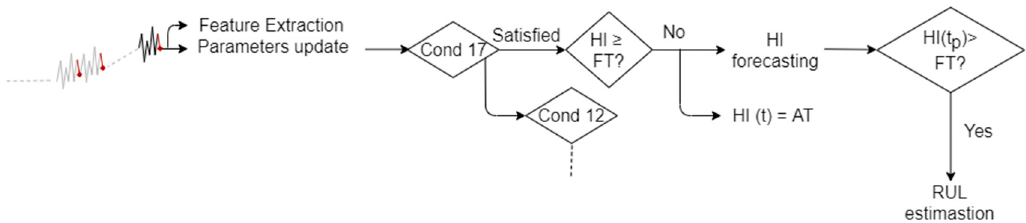
Figure 6. Example of the implementation of the proposed methodology after a fault has been detected.